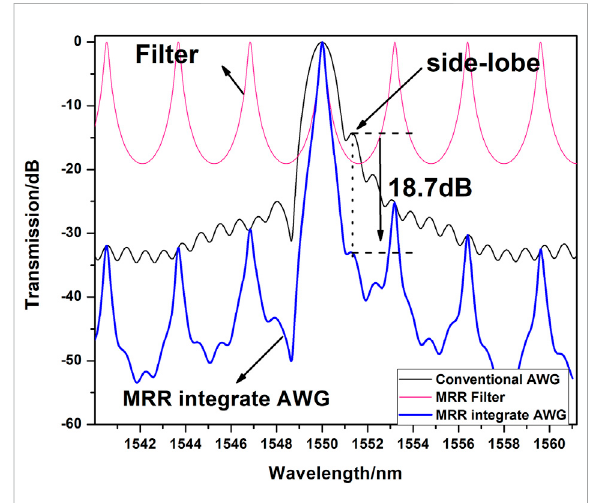
FIGURE 2 Transmission spectra of AWG, MRR fi lter, and the integrated AWG at 1550 nm central wavelength.